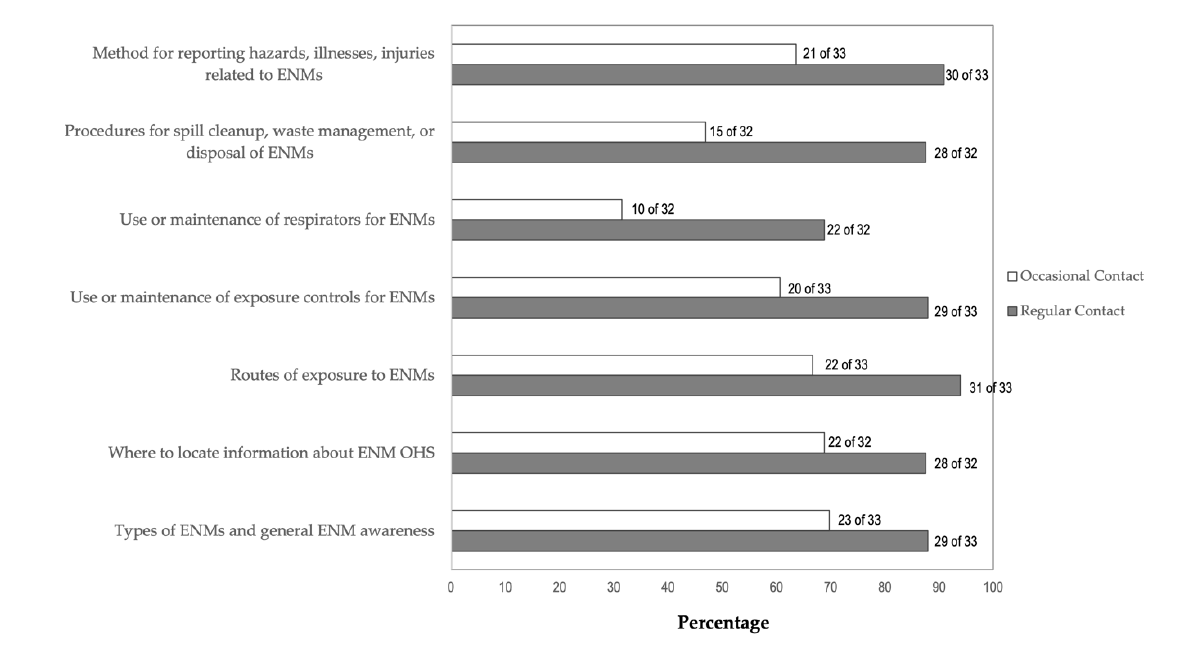
Figure 3. OHS Training for Employees with Regular or Occasional Contact with ENMs. OHS training topics for employees with regular contact (gray bar) or occasional contact (white bar) with ENMs. For all training topics listed, a higher percentage of employees with regular contact with ENMs received training compared to those with occasional contact.